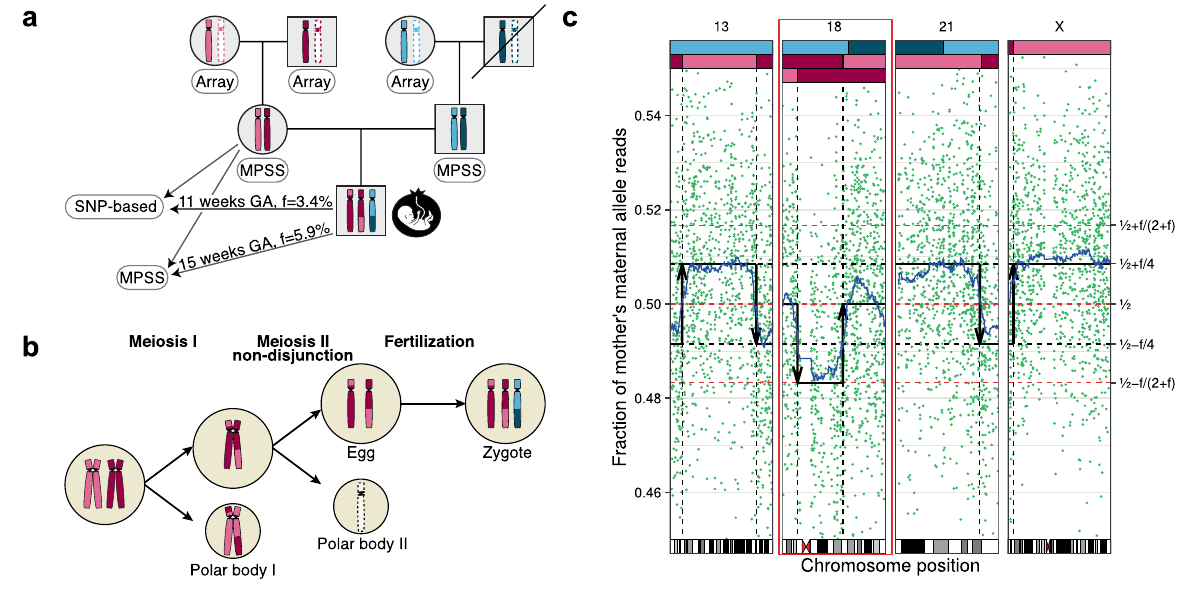
Figure 5. SNP-based targeted sequencing data with chromosomal phase. ( a ) Pedigree with parents and grandparents of the trisomy 18 fetus. MPSS data of DNA from saliva were available for the parents and microarray genotype data of DNA from saliva were available for the grandparents. Data from the SNP-based targeted sequencing and MPSS of maternal plasma using the Illumina Nextseq 500 platform were available at, respectively, 11 weeks and 15 weeks GA. ( b ) Schematic representation of the formation of a trisomic zygote through missegregation of chromosomes during maternal meiosis II. ( c ) Graphical representation of sequence data at loci heterozygous for the mother from the SNP-based targeted sequencing of maternal plasma at 11 weeks GA with a fetal DNA fraction estimated as f = 3.4%. Each green point corresponds to the fraction of the mother’s maternal allele reads at any of the 13,926 SNP loci that are consistent with heterozygous genotypes for the mother and were covered by more than 200 sequence fragments. The two black dotted lines represent the expected fractions of the mother’s maternal alleles in the case of a euploid fetus, and the three red dotted lines represent the expected fractions in the case of a fetus with trisomy of maternal origin. The blue line is a centered rolling mean across 200 consecutive heterozygous SNPs. The top bars represent the inferred inherited homologs of the fetus, with magenta, red, cyan, and blue colors representing, respectively, mother’s maternal, mother’s paternal, father’s maternal, and father’s paternal homologs. Chromosome 18, with three fetal homologs inferred, is highlighted in red. It is important to note that the algorithm to infer the inherited homolog segments takes also into account information about the homologs transmitted from the father of the fetus and allelic fractions at SNP loci consistent with homozygous genotype for the mother and which are not displayed in this figure and that the paternal homologs of the fetus further adds to the sampling noise at loci heterozygous for the